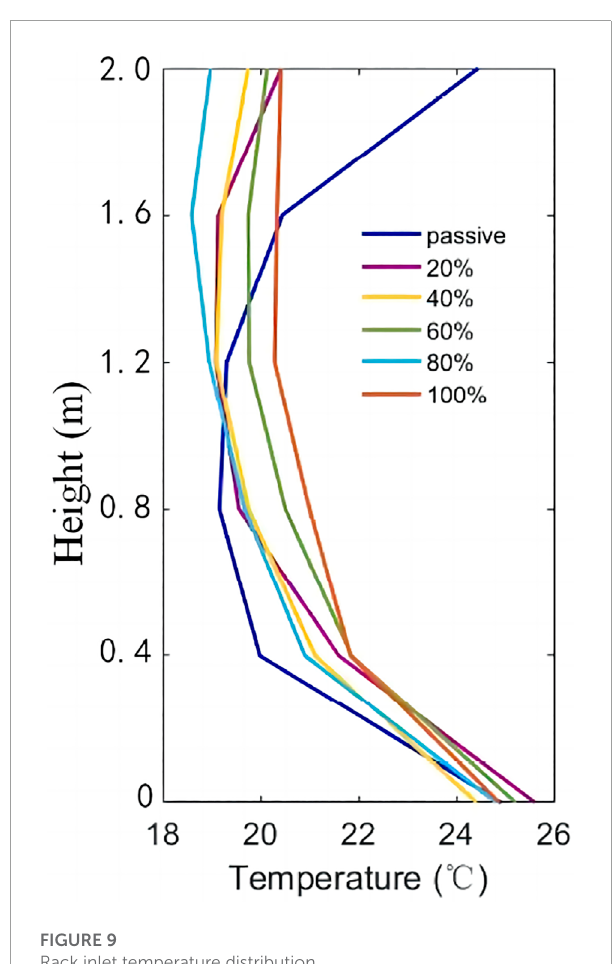
FIGURE 9 Rack inlet temperature